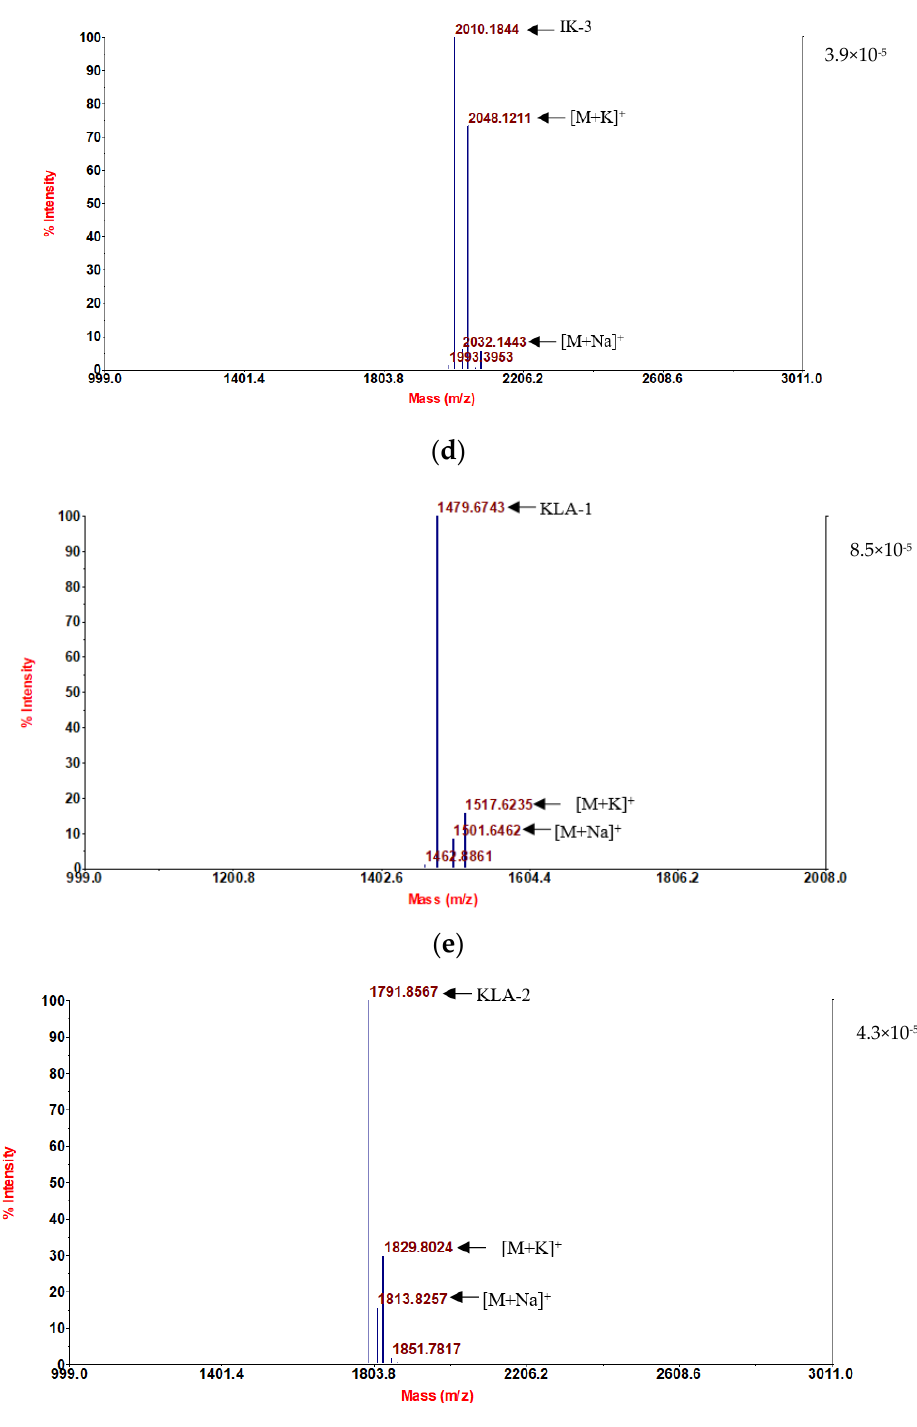
Figure 1. MALDI-TOF MS spectra of the six purified synthetic peptides: ( a ) aurein 1.2; ( b ) IK-1; ( c ) IK-2; ( d ) IK-3; ( e ) KLA-1; and ( f ) KLA-2.